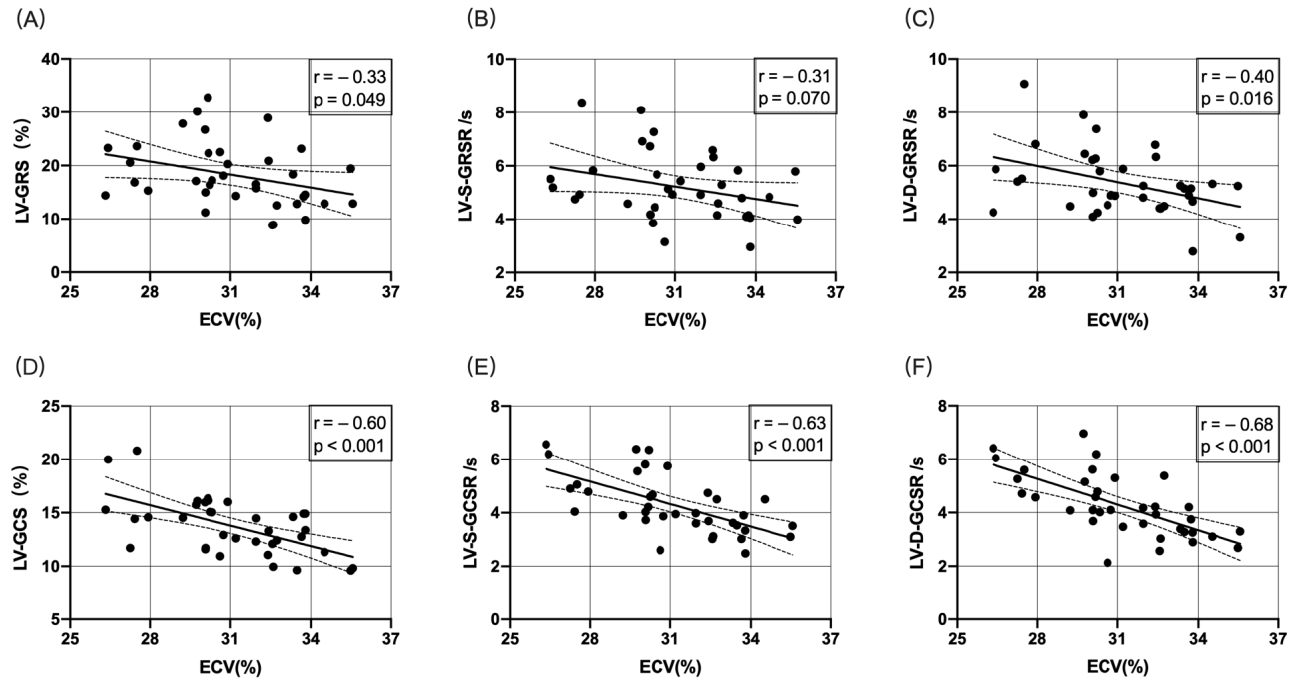
Figure 4. Correlation between ECV and LV-GRS, LV-S-GRSR, LV-D-GRSR, LV-GCS, LV-S-GCSR, and LV-D-GCSR ( A – F ). A significant negative correlation was observed between ECV and LV-derived myocardial strain analysis ( p < 0.05).